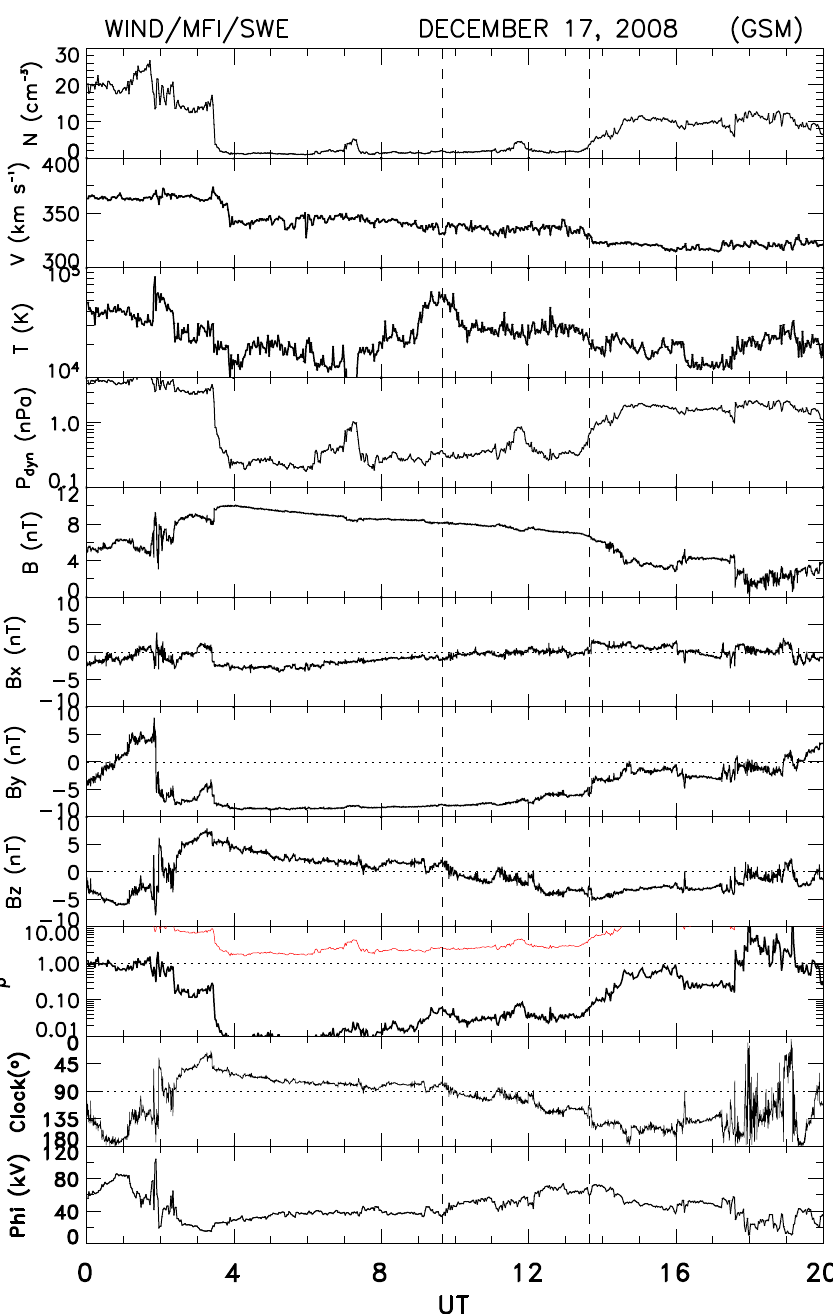
Fig. 2. Wind plot for the interval 00:00–20:00UT, 17 December 2008. From top to bottom the panels show the proton plasma density, bulk speed, and temperature, the dynamic pressure, the magnetic field strength and the magnetic field components in GSM coordinates, the proton plasma beta and, in red, the Alfv´en mach number, and the IMF clock angle, i.e., the polar angle in the GSM (YZ) plane. The interval corresponding to the low-altitude observations discussed in this paper is marked by vertical